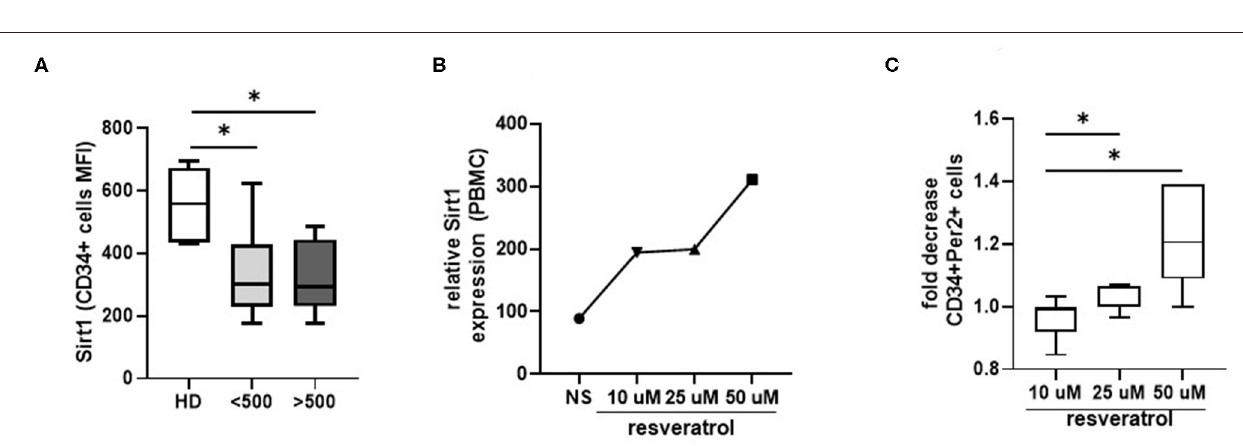
FIGURE 3 | Circulating Per2 expressing-HPC differentiation features. (A) Representative flow cytometry contour plots of Per2 expression in HPC after lentiviral infection: in the square is indicated the percentage of CD34 + Per2 + cells obtained after infection of PBMC with control lentiviral vector (GFP, left panel) or with Per2 specific lentiviral vector (right panel). (B) Colony Forming Cell assay (CFC) showing the absolute value of white and red colonies generated from circulating HPC of HD infected with Per2 specific lentiviral vector or control GFP lentiviral vector. Mann-Whitney test, * p < 0.05.